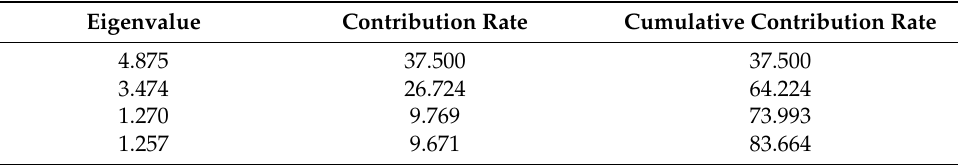
components were obtained from the 13 variables in the social vulnerability index system, and the cumulative contribution rate was 83.66%. Table A1. Time series analysis of high-temperature days.